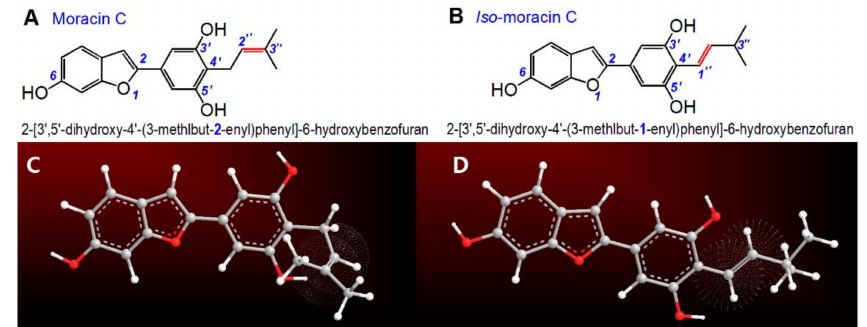
Figure 2. Structures and preferential conformation-based ball-stick models of moracin C and its isomer: ( A ) the structure of moracin C; ( B ) the structure of iso -moracin C; ( C ) the preferential conformation-based ball-stick model of moracin C; ( D ) the preferential conformation-based ball-stick model of iso- moracin C. The ball-stick models were created in Chem3D Pro 14.0. The three-dimensional perspective animations are shown in Video S1 and